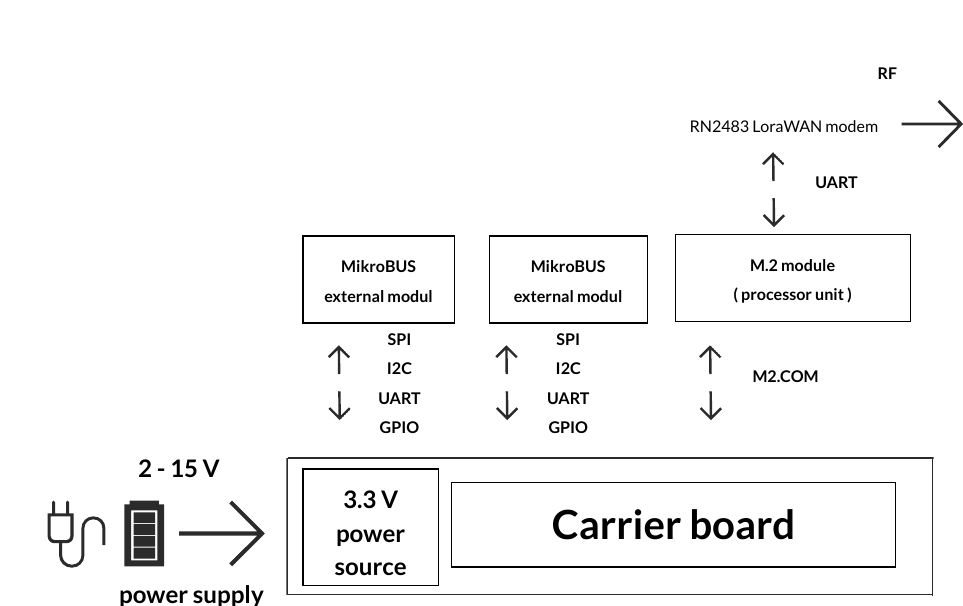
Figure 4. Diagram of the proposed measuring sensor.